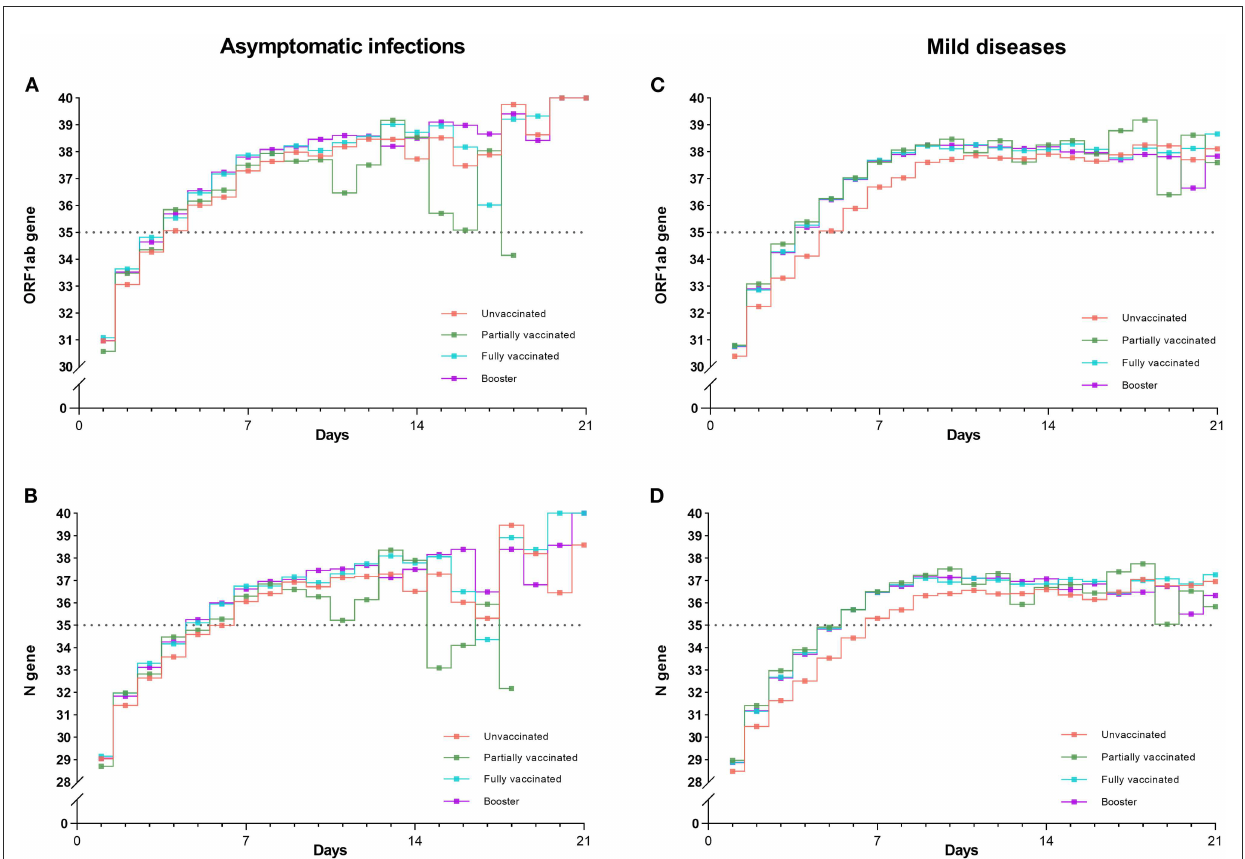
FIGURE5 Trends of mean Ct values (ORF1ab and N genes) for four vaccinations in asymptomatic infections and mild diseases. Trends of Ct values for four vaccinations were almost the same in asymptomatic infections (A, B) . In contrast, the Ct values of the unvaccinated individuals were significantly lower than those of the other three vaccination groups in mild diseases (C, D) ( P <